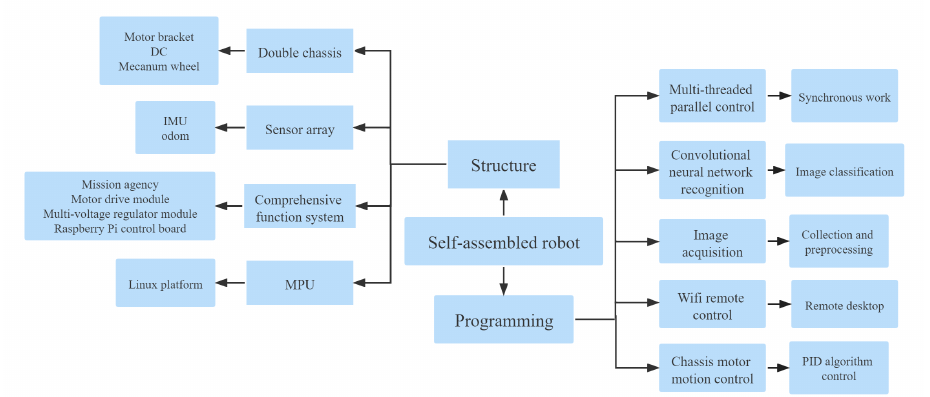
Figure 3. Architecture diagram of robot assembled in